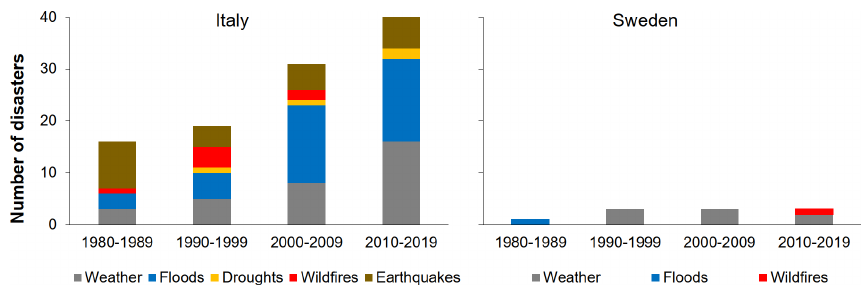
Figure 2. Contrasting landscapes of risk. Number of natural hazards that turned into disasters in Italy and Sweden. The label “Weather” is used for meteorological extremes according to EM-DAT terminology, i.e., storms and extreme temperature events (cold/heat waves).